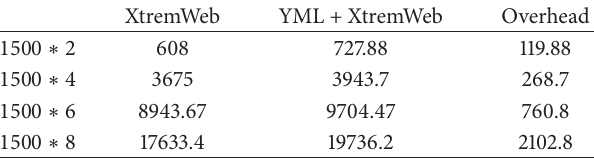
Table 2: Overhead of YML on